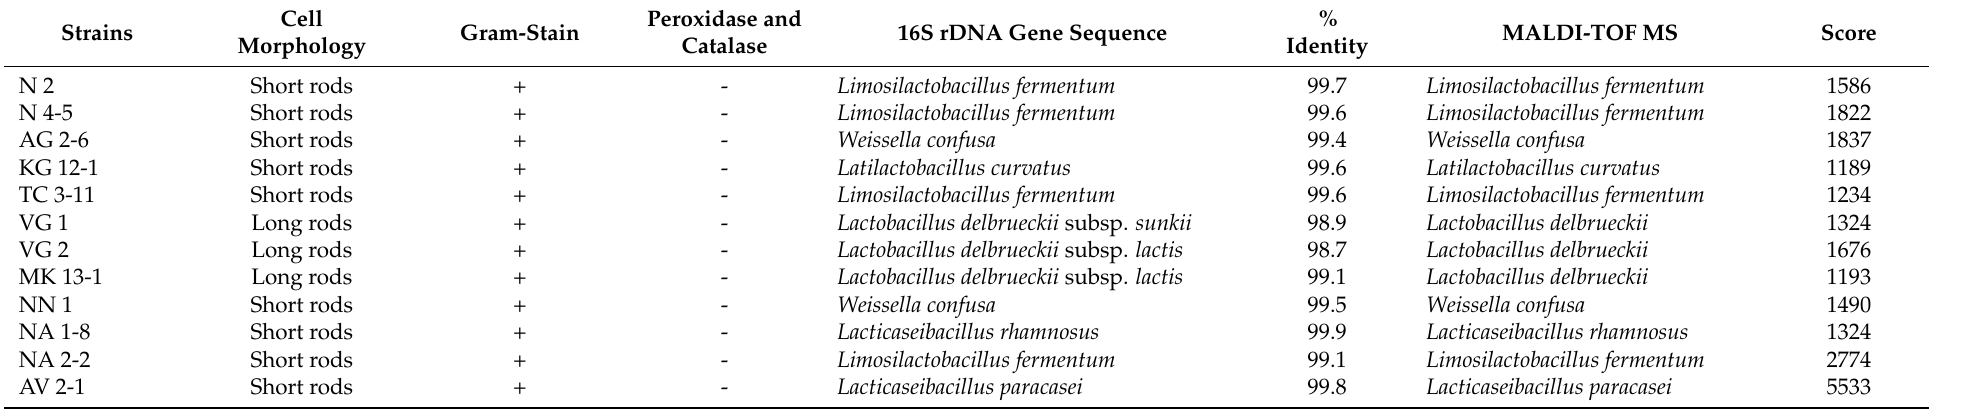
Table 1. Characterization and identification of the newly isolated